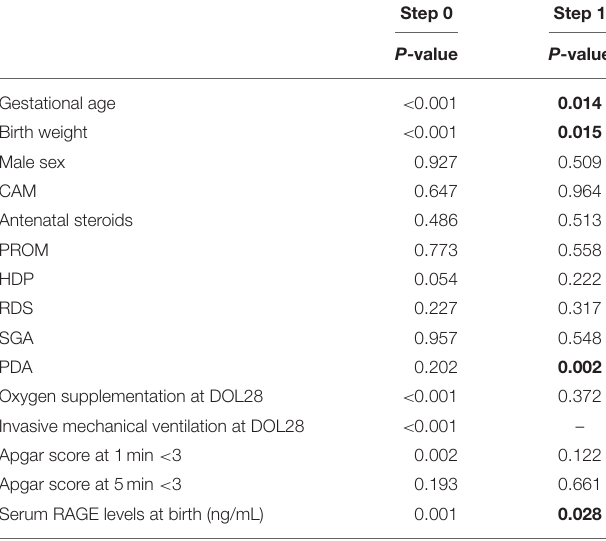
TABLE 2 | Perinatal factors affecting serum RAGE levels in term and preterm neonates.